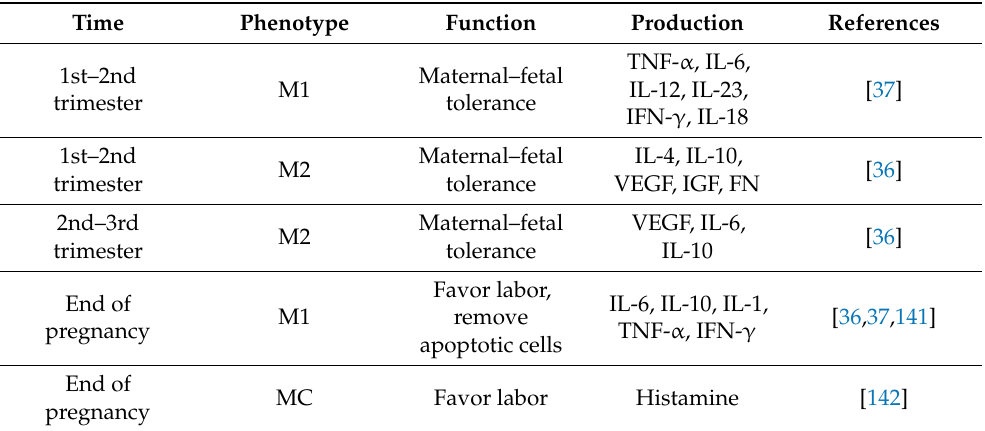
Table 4. Placental MCs and M φ s: Appearance, function, and biomolecules produced during dif- ferent stages of pregnancy. Abbreviations: MC C —mast cell chymase, MC TC —mast cell